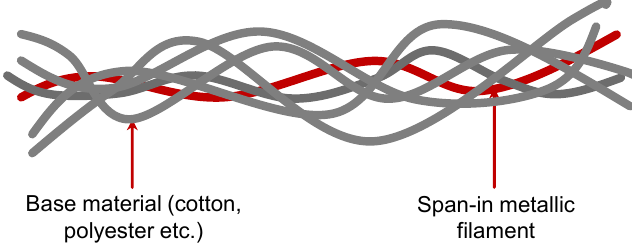
Figure 10. A schematic of conductive fibre twisted with normal fibres. Electrically conductive fabrics are developed by weaving conductive yarns into the textile structures or applying metallic coatings on the yarn or fabric [89]. Examples of layer and a conductive yarn consisting of metal multifilaments are presented in Figure 11.